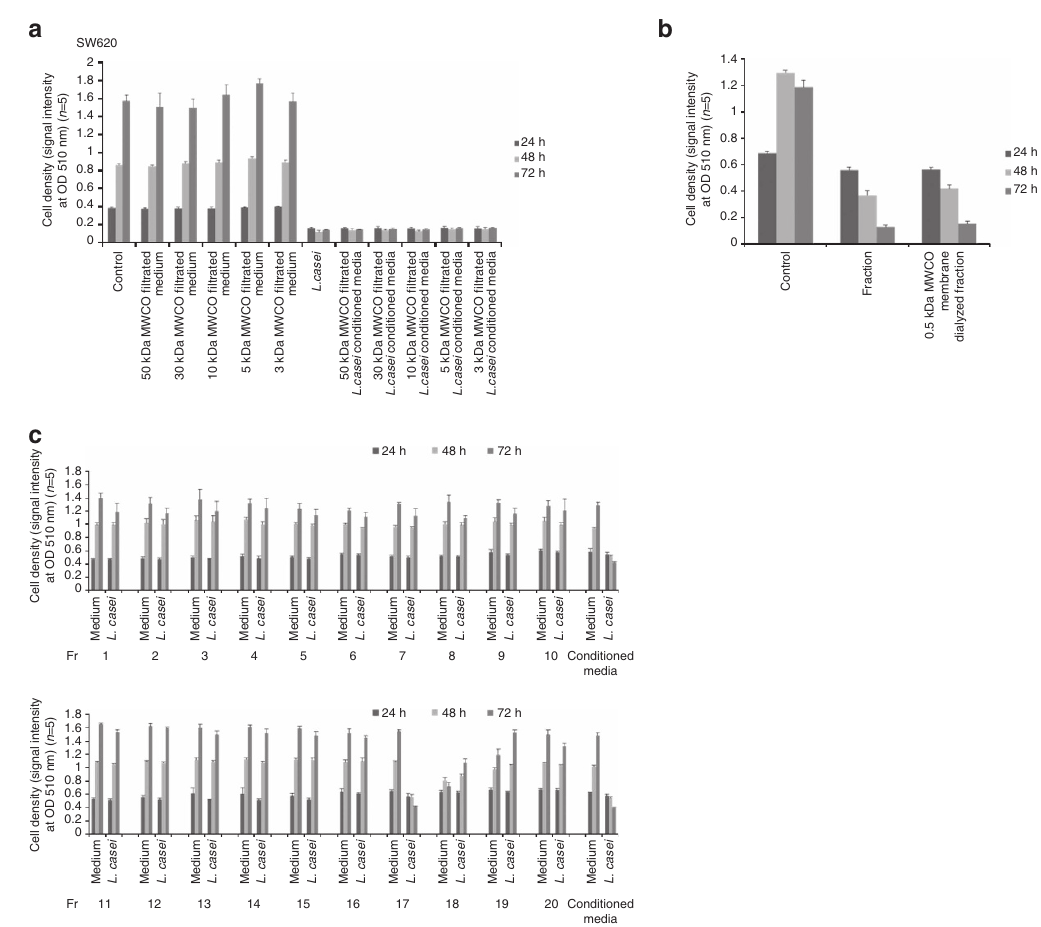
Figure 2 | The tumour-suppressive effect of low molecular weight fraction from the L. casei ATCC334 culture supernatant. The tumour-suppressive effects of the L. casei ATCC334 culture supernatant fractions were examined after filtration through 3-, 5-, 10-, 30- or 50-kDa membranes ( a ). The tumour-suppressive fraction was dialyzed using a 0.5kDa dialysis device ( b ). A tumour-suppressive effect was confirmed in the fractions that were separated from the L. casei ATCC334 culture supernatant by size-exclusion chromatography ( c ). The conditioned medium of L. casei was used as a positive control in the following study. The fractions were assessed using reverse-phase chromatography and a tumour-suppressive effect was identified in the 17th fraction by size-exclusion